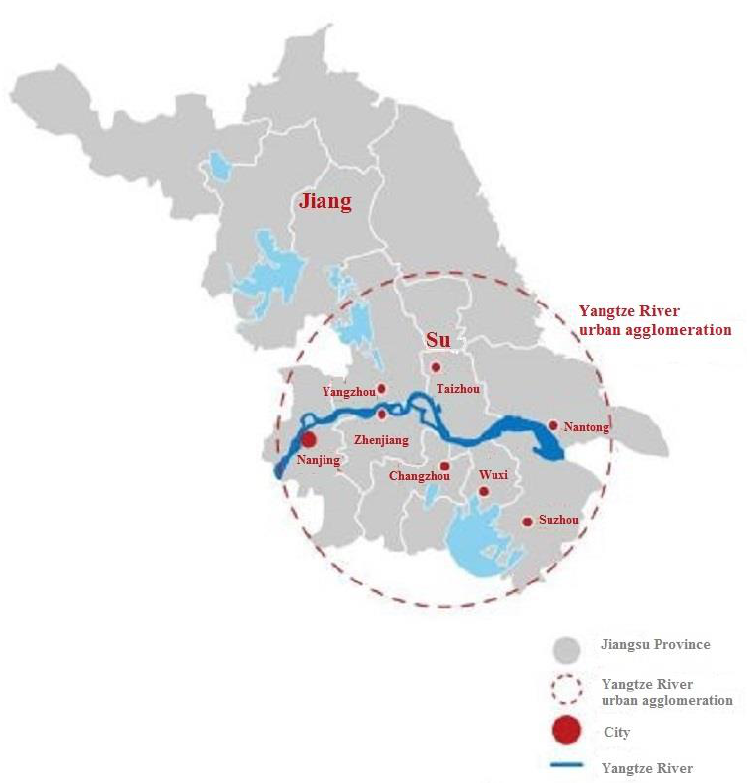
Figure 1. Map of the Yangtze River urban agglomeration.